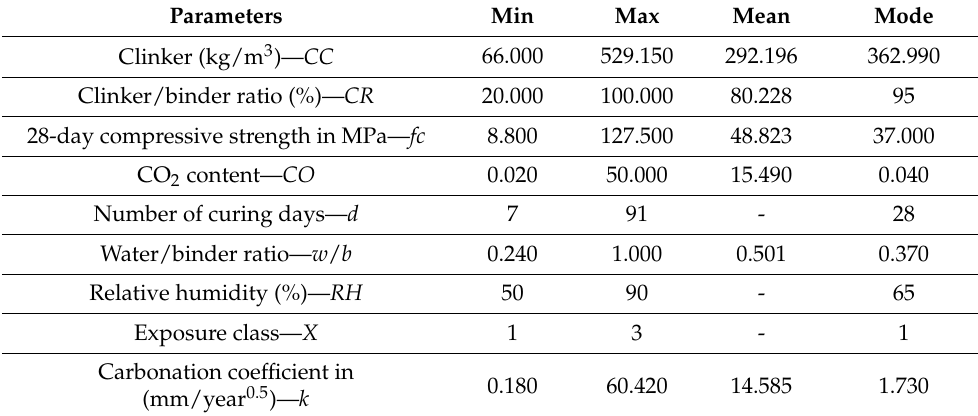
Table 1. Details of the data used for model